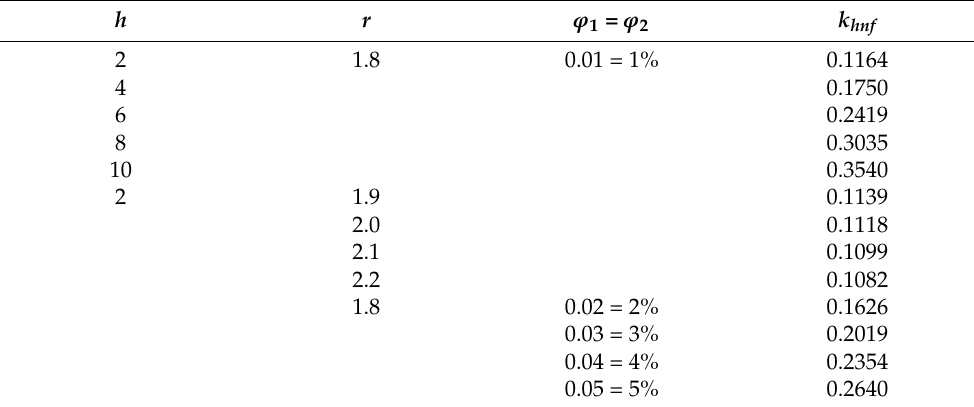
Table 3. Effect of nano-layer thickness (h), radius (r), and volume fraction ( ϕ 1 , ϕ 2 ) of particles on T.C